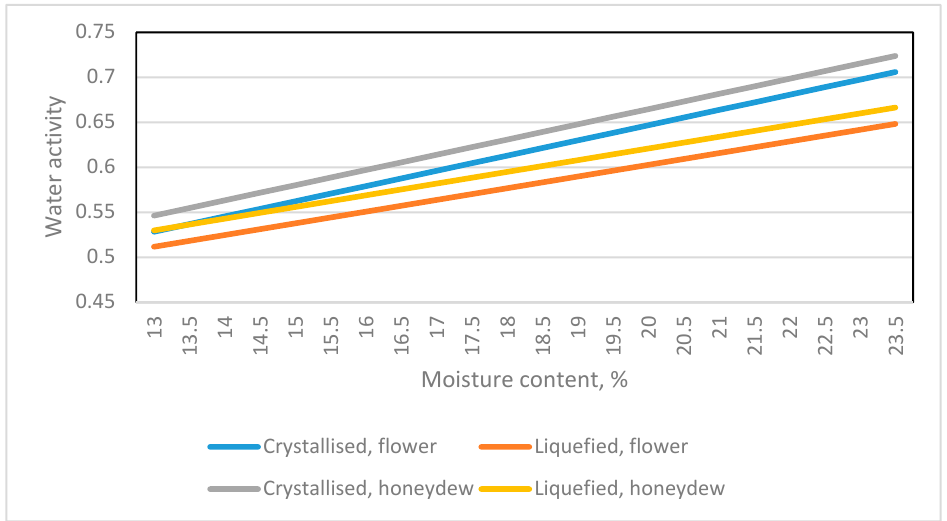
Figure 7. The prediction equations between water activity and moisture content including different type (flower and honeydew) and state (liquid and crystallized) of honey [8].